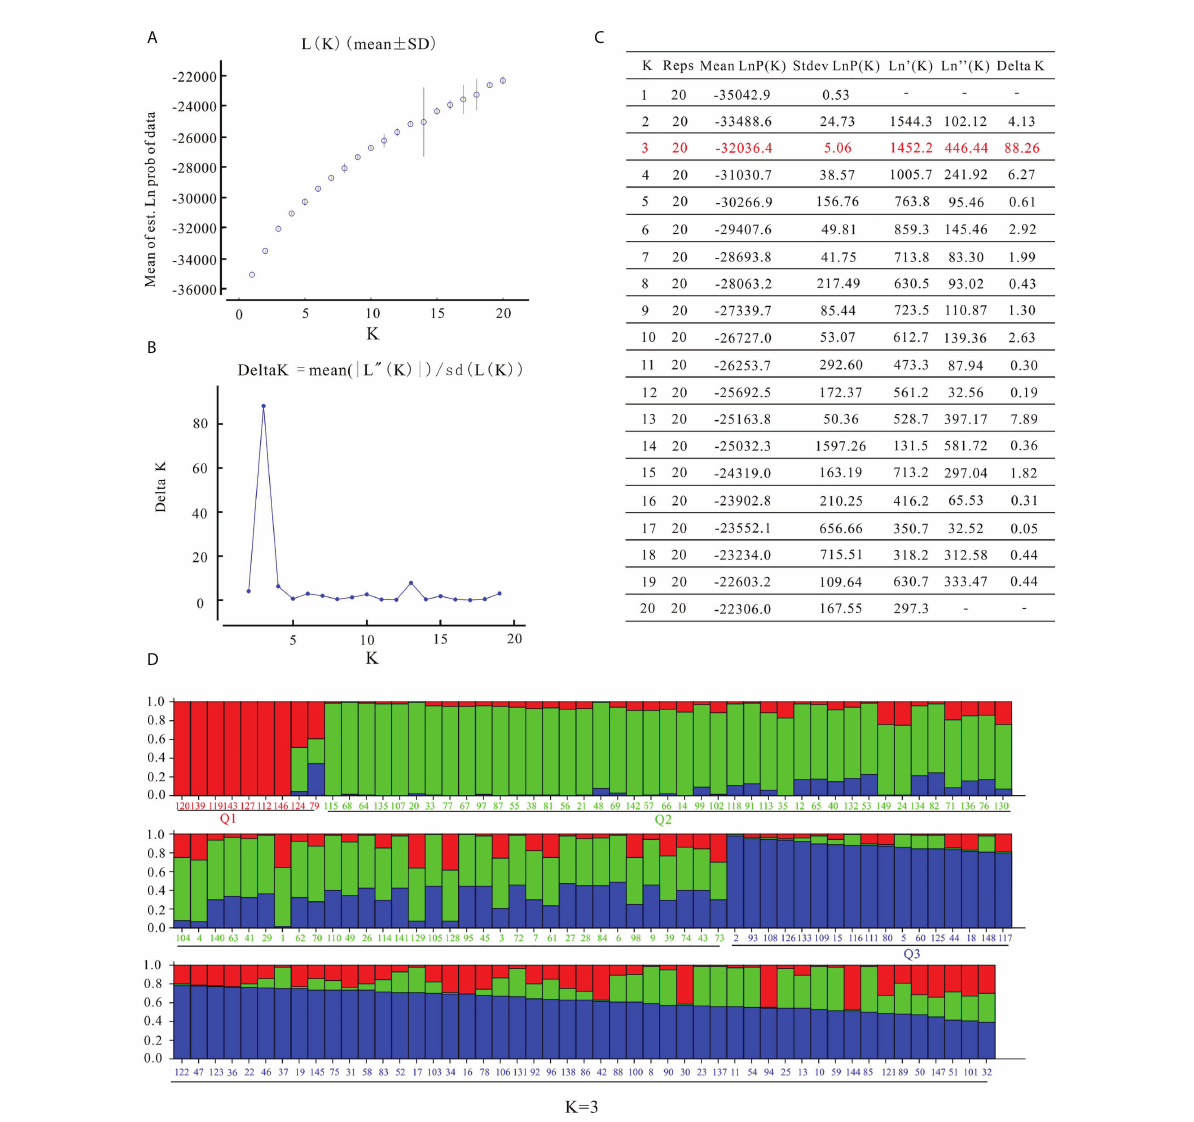
FIGURE 3 Analysis of population structure of 149 potato varieties. (A) Mean log-likelihood [Ln(K) ± SD], (B) △ K values, (C) each K value based on the model reported in the article Evanno et al. (2005), (D) population structure of 149 potato varieties on K values of 3. The colored bar grouped the varieties in the corresponding populations, red, Q1 group; green, Q2 group; blue, Q3